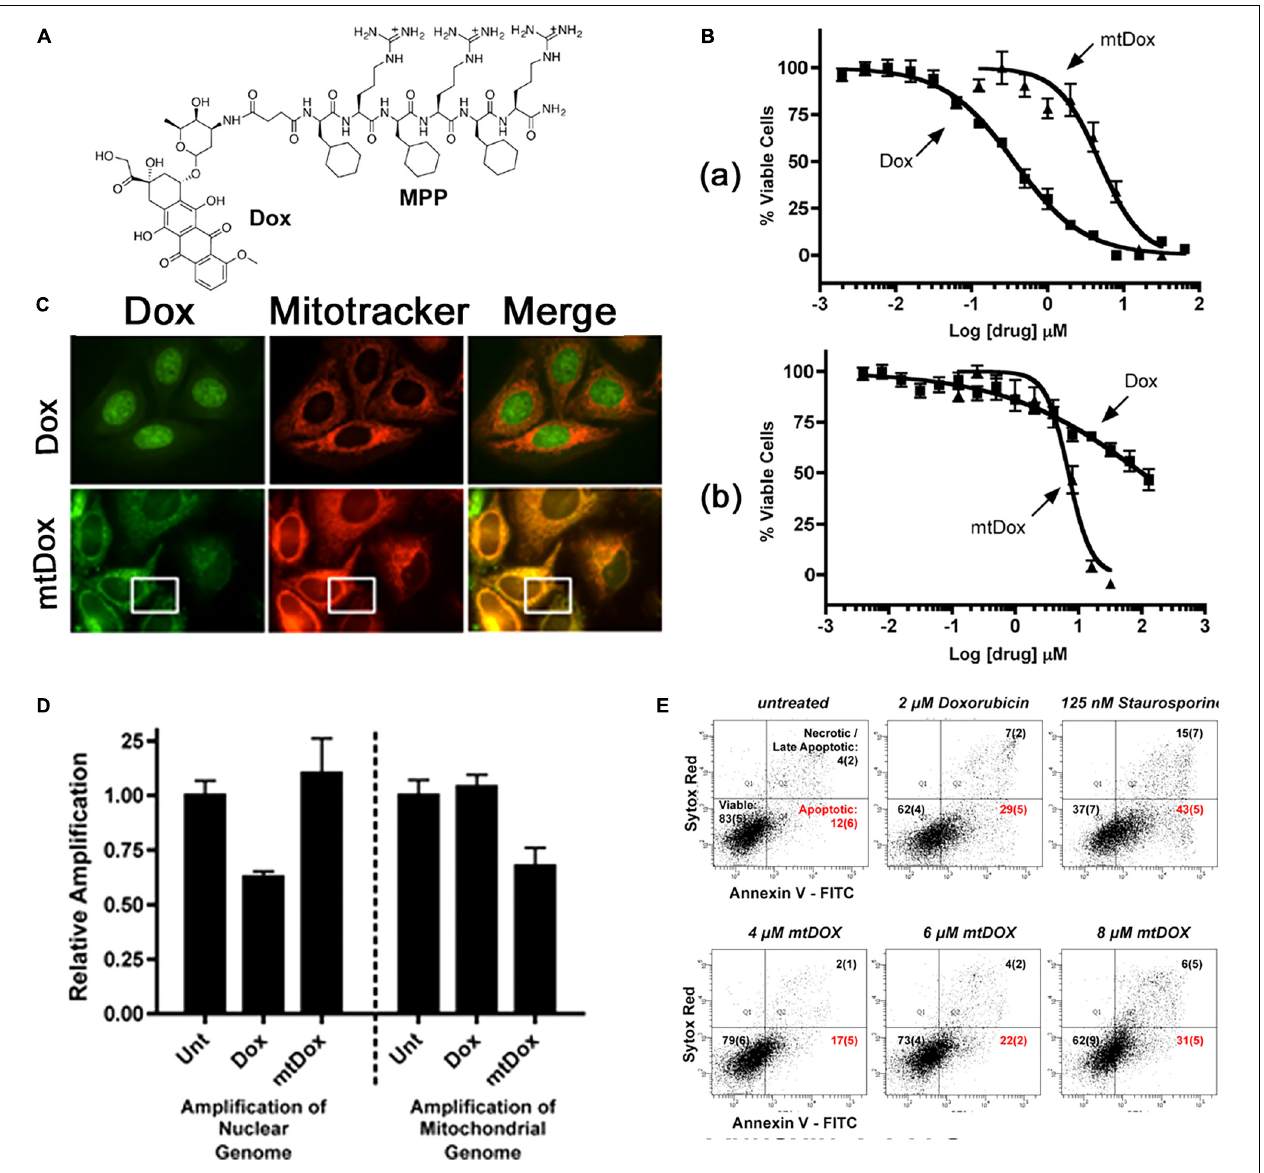
FIGURE 1 | (A) Chemical structure of mtDox. (B) Cytotoxicity data. (a) mtDox and Dox are both toxic to sensitive A2780 cells. (b) The toxicity of Dox is highly attenuated in A2780ADR Pgp-expressing cells. (C) Intracellular localization of mtDox by confocal microscopy, Dox and mtDox (green channel) and Mitotracker 633 (red channel). (D) Assessment of DNA strand breaks in cells by measuring the relative amplification of nuclear and mitochondrial DNA segments. (E) Flow cytometry analysis of A2780 Annexin V-FITC (A-FITC)/SYTOX Red (SR) cell staining. Images were adapted with permission from reference (Chamberlain et al.,